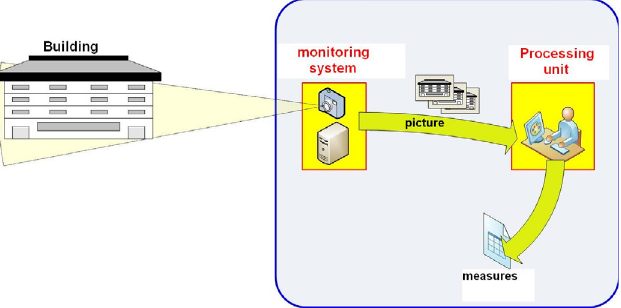
Fig. 11. Video camera system for windows and blinds monitoring.